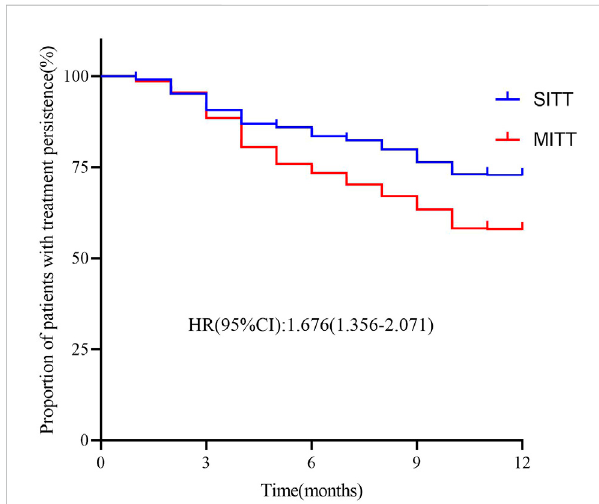
FIGURE 2 Kaplan – MeiergraphsfortreatmentpersistenceinSITTandMITT.